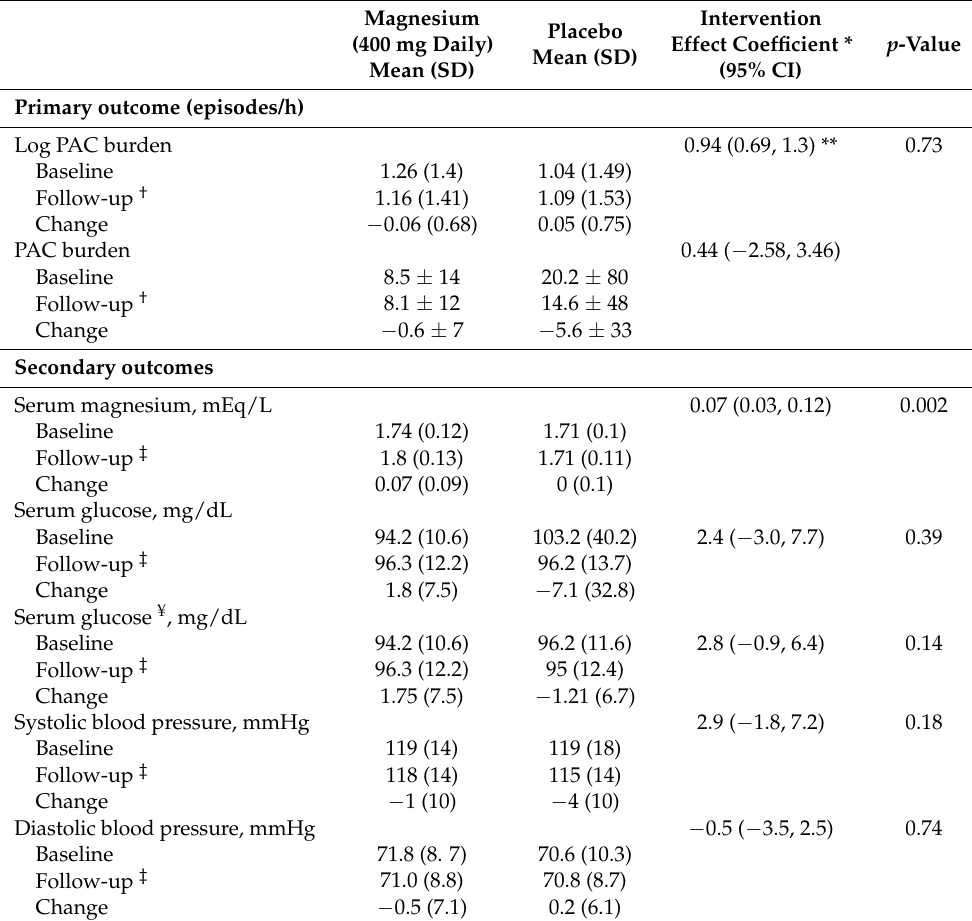
Table 3. Change in PACs and secondary endpoints (i.e., systolic blood pressure (SBP), diastolic blood pressure (DBP), serum glucose, serum magnesium) according to treatment group.